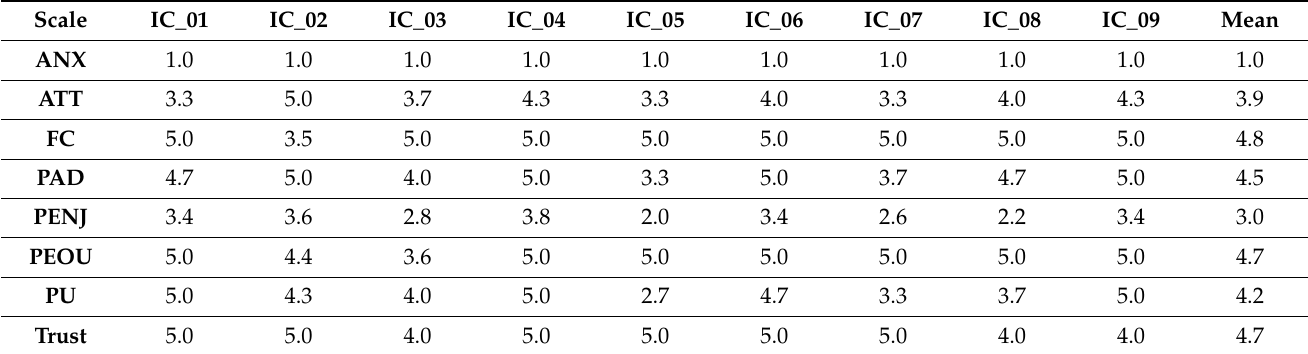
Scale from 1 to 5. ANX: Anxiety, ATT: Attitude, FC: Facilitating Conditions, PAD: Perceived Adaptability, PENJ: Perceived Enjoyment, PEOU: Perceived Ease of Use, PU: Perceived Usefulness; IC = Informal Caregiver (named from IC_01 to IC_09).